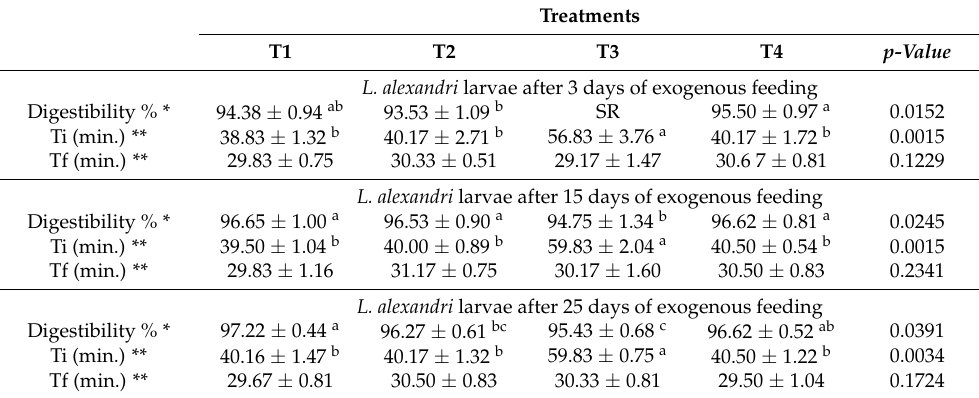
Table 5. Values (mean ± standard deviation) of digestibility, initial time of fecal production and final time of fecal production of Lophiosilurus alexandri larvae of different ages fed with Artemia nauplii with different